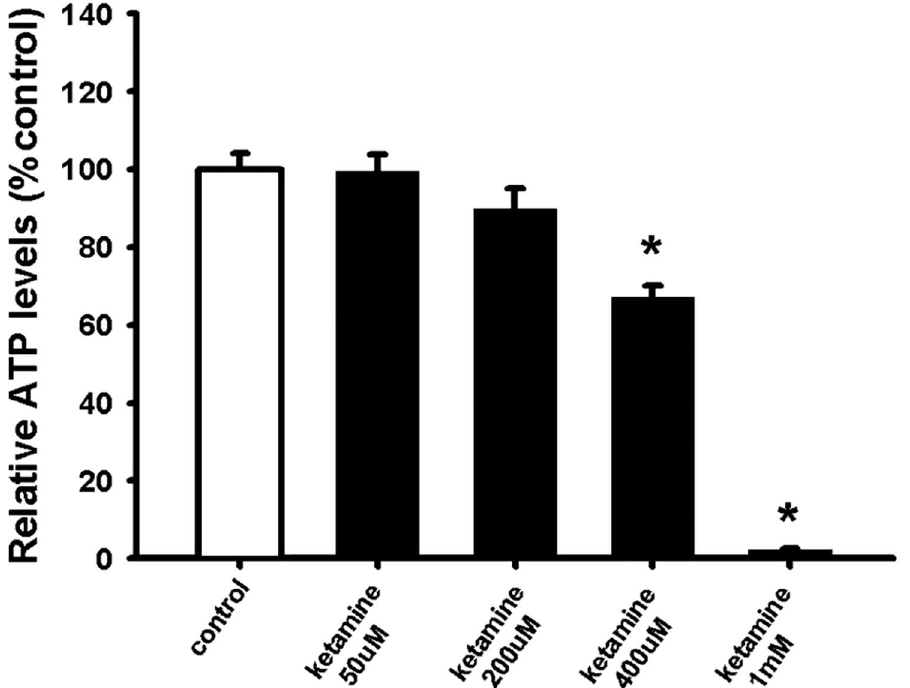
Fig 1. Ketamine decreasesNSC viability in a dose-dependent manner. NSCs were platedas single cells treated with 50 μ M, 200 μ M, 400 μ M and 1 mM ketamine. To measurecell viability, intracellularATP levels were measuredafter 24 hours. Data are shown as mean ± SEM (n = 22–35). Kruskal-Wallis followedby Dunn’stest was used. Differences were considered significantat P < 0.05. * denotesP < 0.05comparedwith